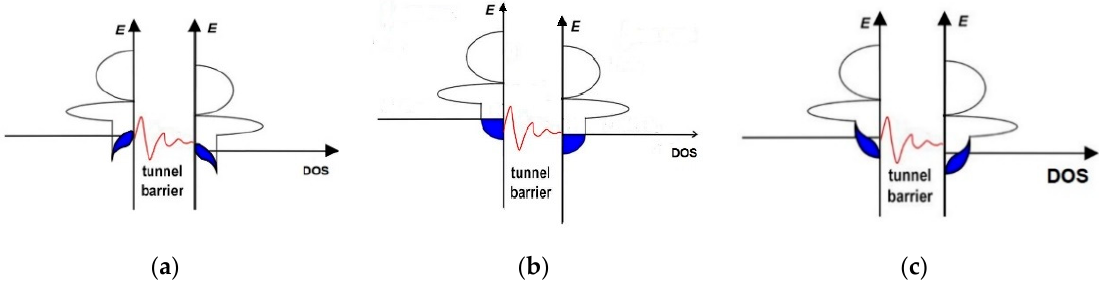
Figure 1. Tunneling FM/barrier/FM for X SFMO > X barrier ( a ), X SFMO = X barrier ( b ), and X SFMO < X barrier ( c ). Energy is plotted along the vertical axis, and the density of states of the FM layers is plotted along the horizontal axis. Filled states are shown in blue. A negative bias voltage, V , has been applied to the sample, which effectively raises its Fermi level by e·V with respect to the Fermi level of the grounded FM electrode.